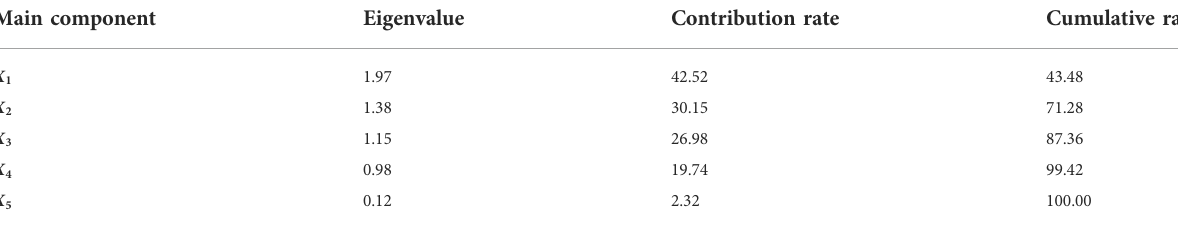
TABLE 1 Eigenvalue of covariance matrix of fi ve